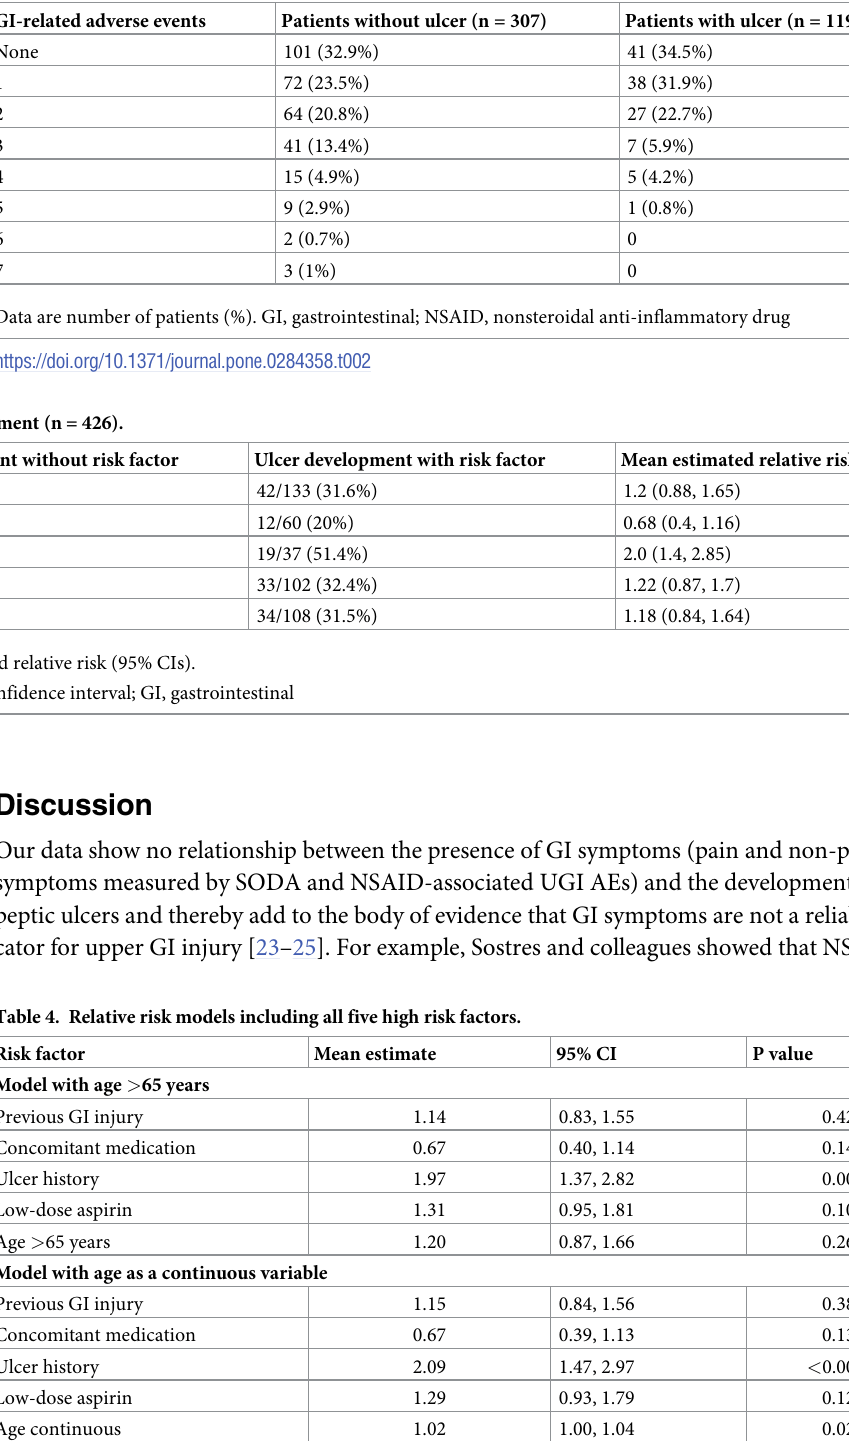
Table 2. Proportion of patients with NSAID-associated upper gastrointestinal adverse events under naproxen treatment (n = 426).